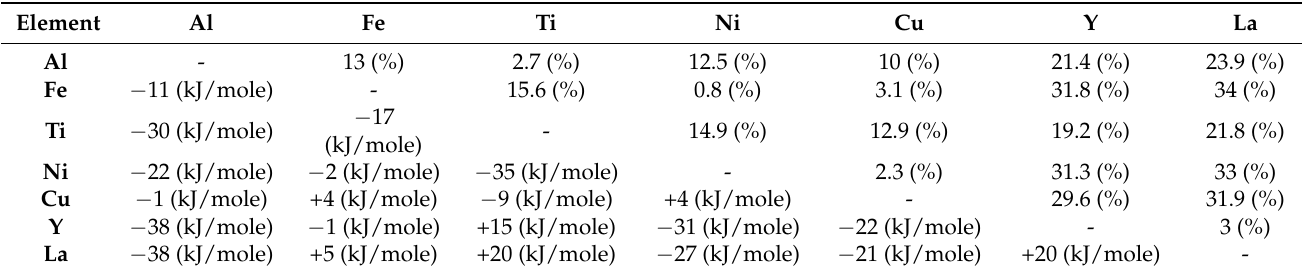
Figure 2. Particle size distribution of ( a ) Al 82 Fe 16 Ti 2 , ( b ) Al 82 Fe 16 Ni 2 , and ( c ) Al 82 Fe 16 Cu 2 powders after 40, 50, and 60 h of milling, respectively; ( d ) cumulative distribution of three alloy powders. Table 1. Atomic radii mismatch (in %) and enthalpies of mixing (in kJ/mole) for Al, Fe, Ni, Ti, Cu, Y, and La binary systems. [30].